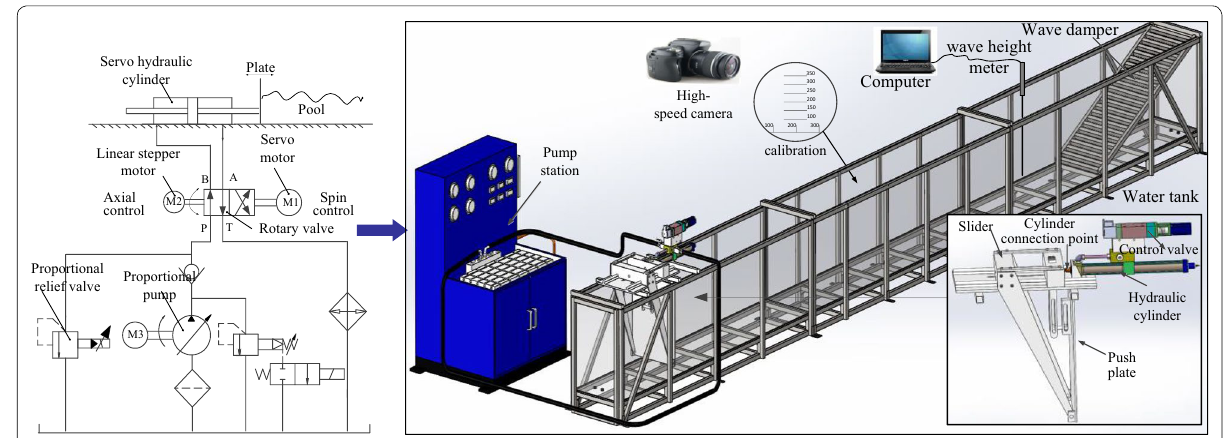
Figure 1 Working principles of electro-hydraulic control system and wave experiment